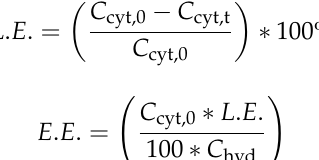
Figure S1: Swelling efficiencies of different shaped AuNPs, Figure S2: ln( F ) vs. ln( t ) plots for AuNR (a) Part-I; (b) Part-II; AuHex (c) Part-I; (d) Part-II; AuBP (e) Part-I; (f) Part-II; (g) Part-III; AuNM (h) Part-I; (i) Part-II; (j) Part-III; AuNS (k) Part-I; (l) Part-II. Table S1: Physico-chemical properties of different shaped